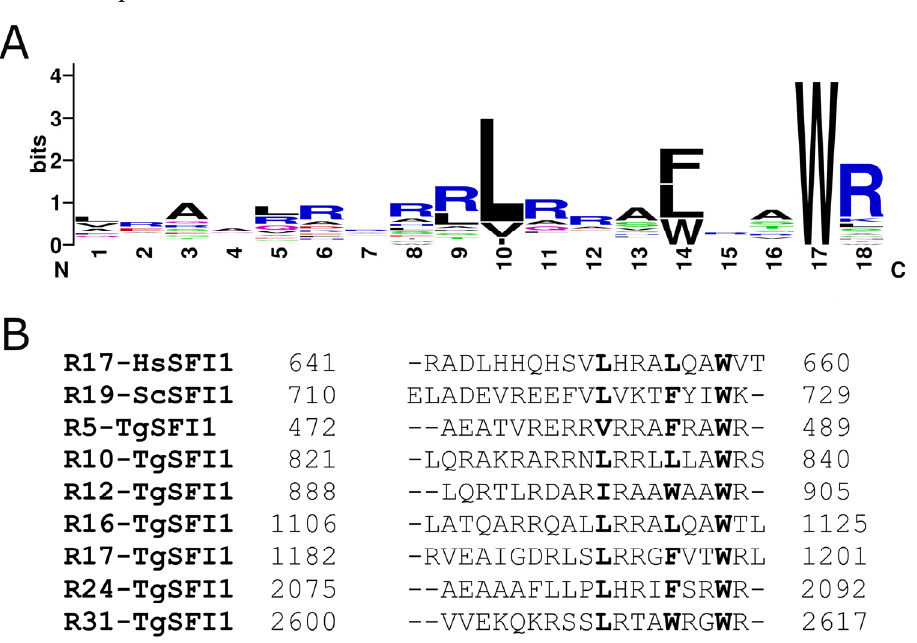
triad, seven peptides corresponding to different representative repeats of the TgSFI1